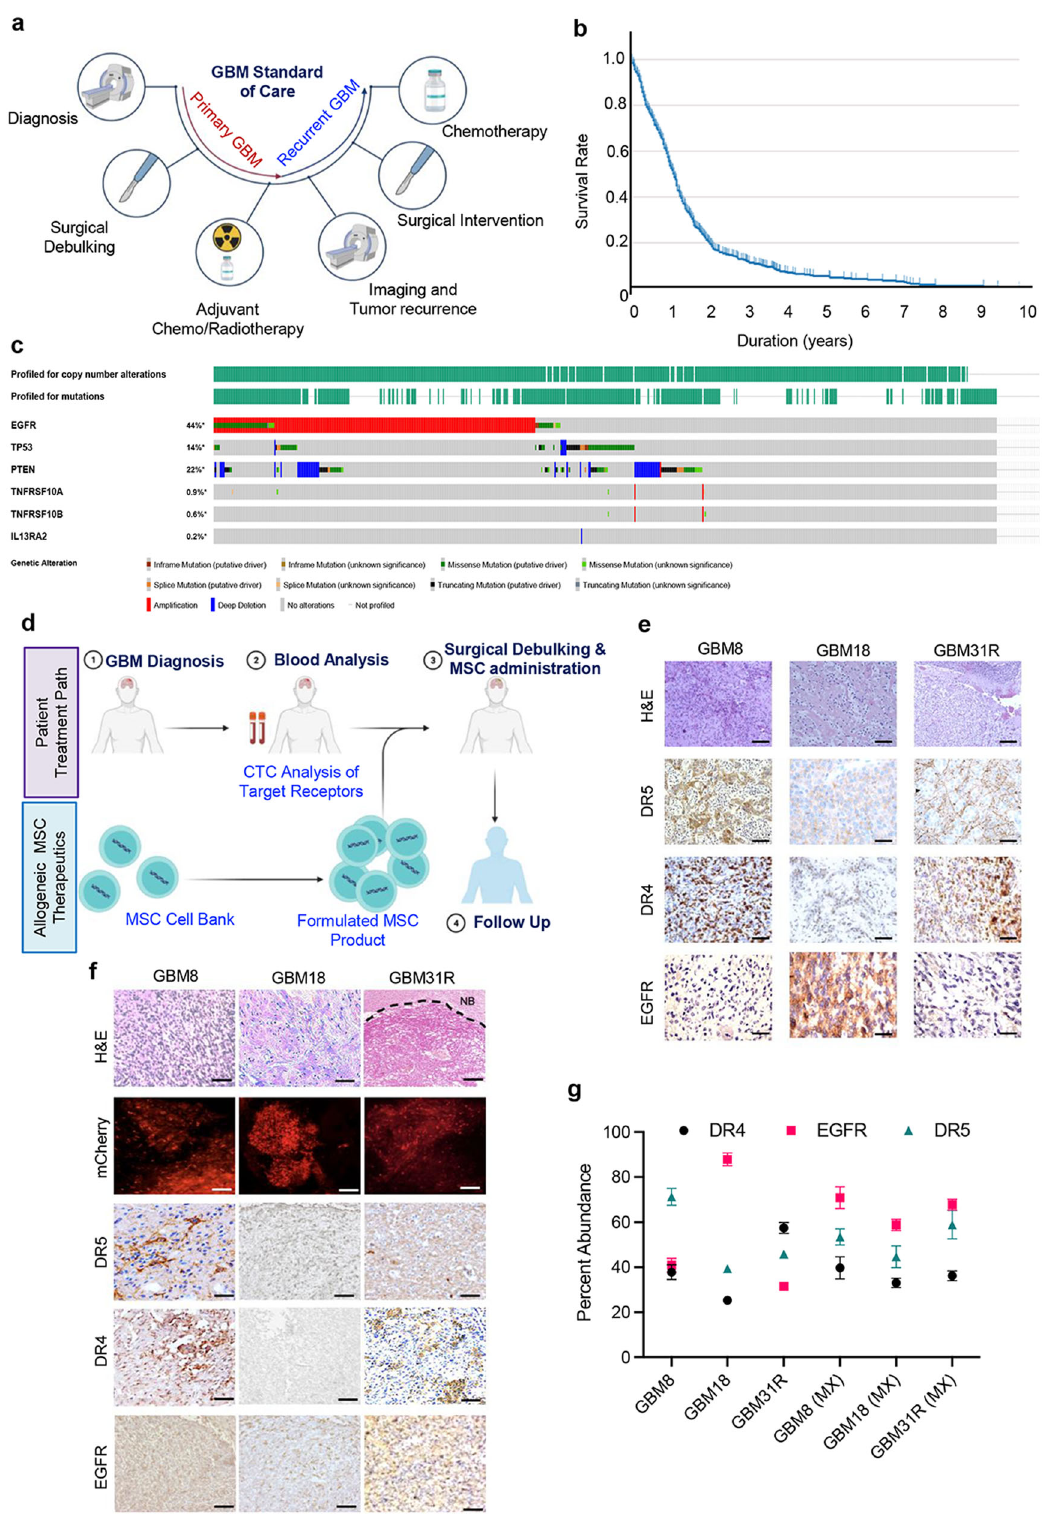
mean capture percentage for GBM8-FmC, GBM-18 FmC, and GBM31R-FmC cells was 81.3, 75.33, and 79.33%, respectively (Supplementary Fig. 1c). To compare the receptor expression patterns of GBM CTC, we isolated CTC from blood samples of mice bearing patient-derived GBM8-FmC, GBM18-FmC, and GBM31R-FmC tumors using the experimental plan outlined in Fig. 2a. The blood samples obtained at various time points of